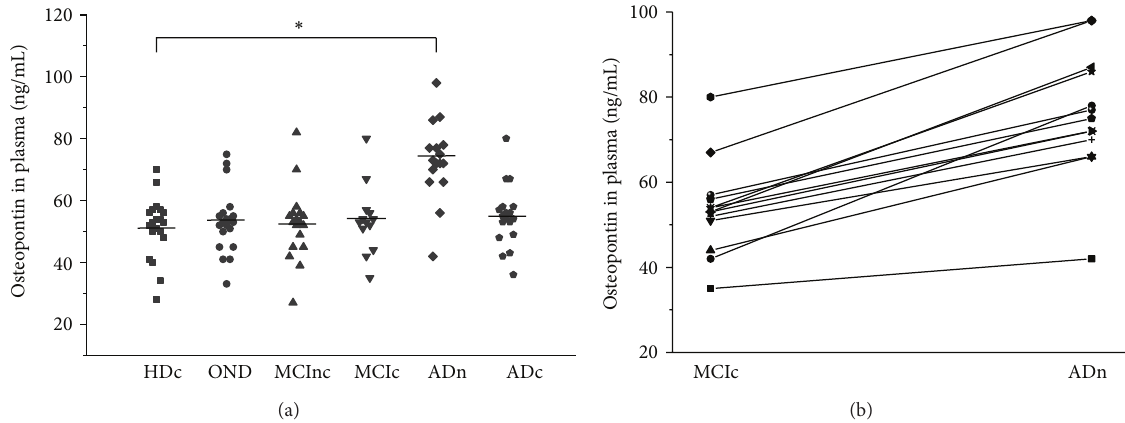
Figure 1: Plasma osteopontin levels in newly diagnosed Alzheimer’s disease (AD) are elevated. The horizontal lines represent the mean values of each group, and asterisks show statistical significance ( ∗ 𝑃 < 0.01 ). (a) Osteopontin concentrations in plasma of 20 healthy control (HC), 20 aged-matched other noninflammatory neurologic diseases (OND), 18 clinically stable mild cognitive impairment patients (MCInc), 13 mild cognitive impairment converters (MCIc), 17 newly diagnosed AD (ADn), and 18 chronical AD patients (ADc) were determined using an enzyme-linked immunosorbent assay (ELISA). (b) The plasma osteopontin concentrations within the same individual ( 𝑛 = 13 ) at different disease statuses.